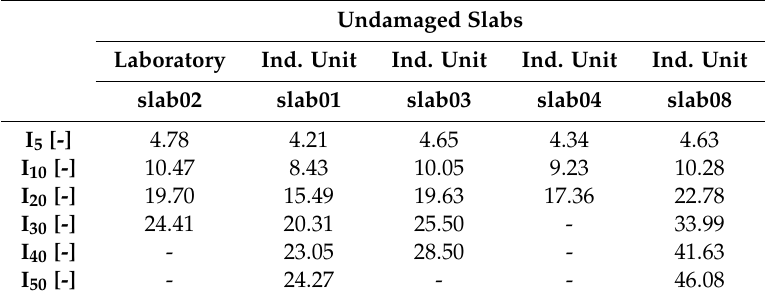
Table 9. Summarization of toughness index data.